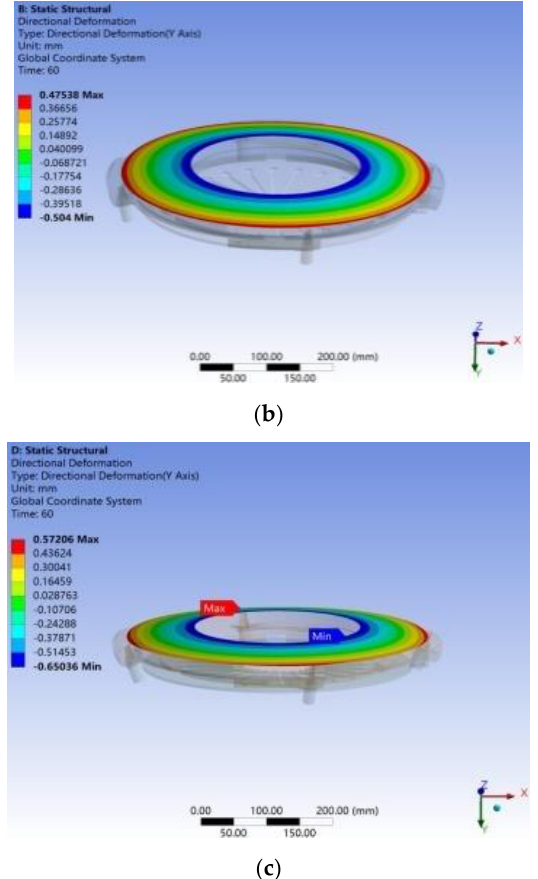
Figure 5. The temperature field ( a ), deformation field under constraint condition 1 ( b ), and deformation field under constraint condition 2 ( c ) of pressure plate at 60 s.